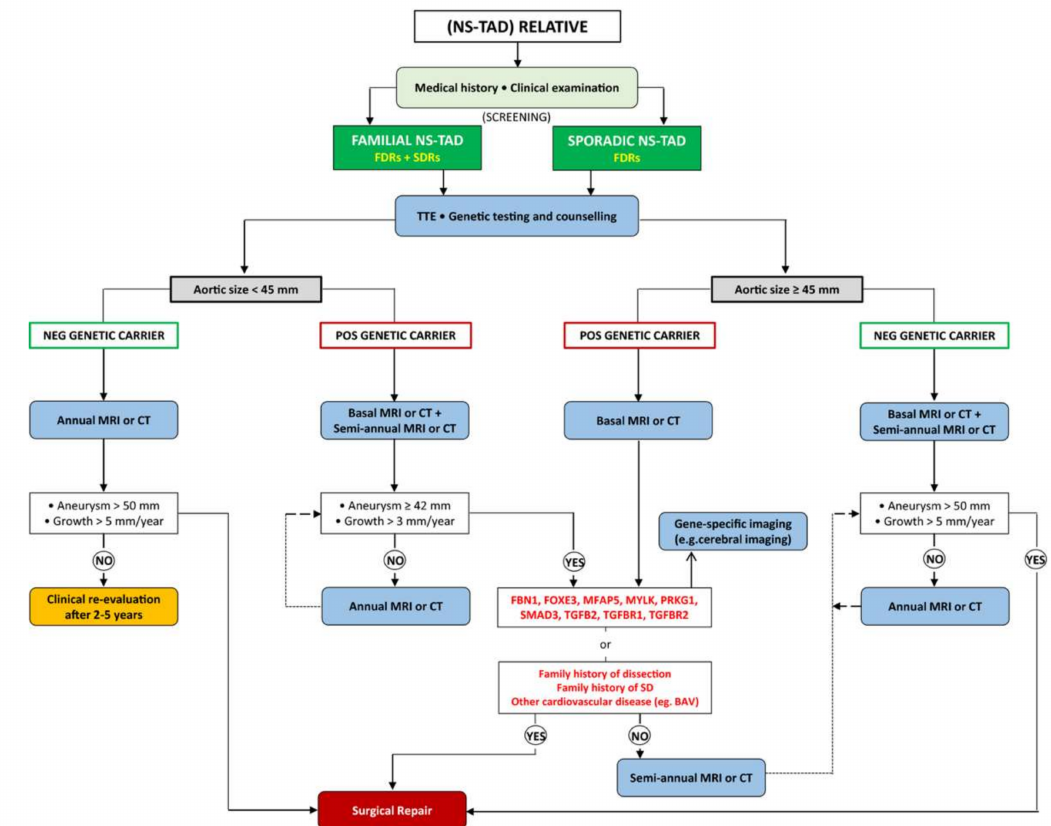
Figure 6. Proposed flow chart for a dedicated screening program for relatives of patients a ff ected by non-syndromic diseases of the thoracic aorta. Note the importance of genetic screening in stratifying patients. BAV indicates bicuspid aortic valve; CT, computed tomography; FDRs, first-degree relatives; MRI, magnetic resonance imaging; NS-TAD, non-syndromic thoracic aortic disease; SDRs, second-degree relatives; TTE, transthoracic echocardiogram. © 2020 by Mariscalo et al.